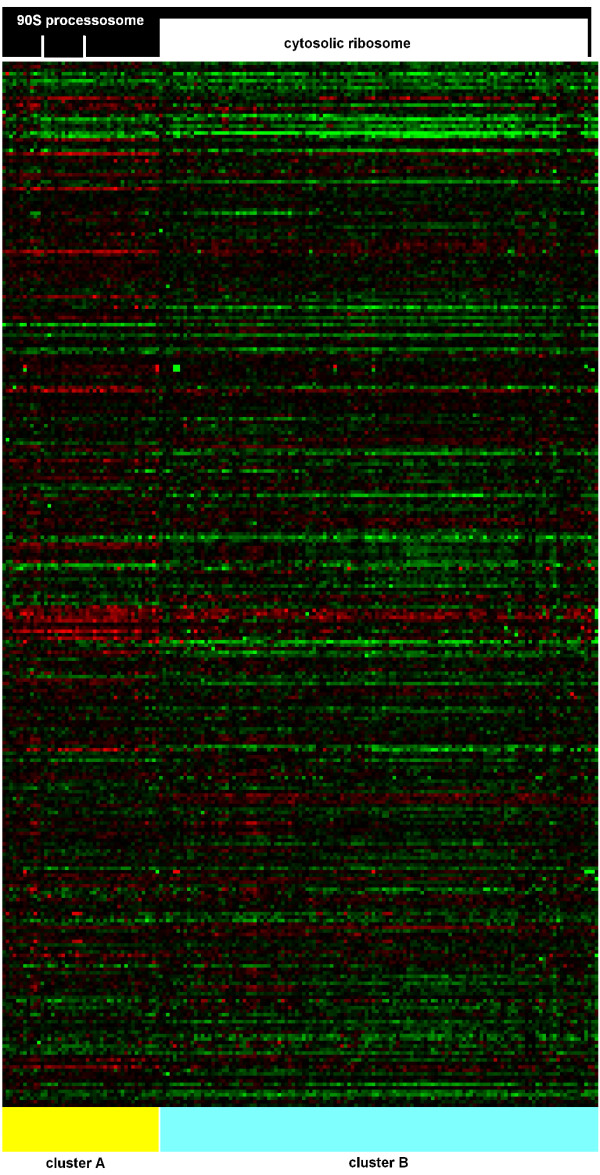
Hierarchical clustering of gene expression patterns of ribosomal and processosomal protein genes. The central plot shows color-coded expression ratios as supplied in the ROSETTA expression compendium [47] for genes encoding ribosomal and 90S-processosomal proteins. Genes vary along the horizontal axis, expression experiments vary along the vertical axis. Top: 90S-processosomal genes are marked in black, ribosomal protein genes are marked in white. Bottom: hierarchical clustering yields two large clusters, here marked in cyan and in yellow, that comprise approximately 80% of all ribosomal/processosomal genes (171 of 211). Only genes of these clusters are shown here. Note that only three genes are not clustered according to their membership to either the ribosome or the 90S processosome. The separation of the 90S processosomal and ribosomal protein genes by hierarchical clustering (an unsupervised approach) confirms that the ribosomal and 90S processosomal expression programs are distinct from each other (Figure 5).